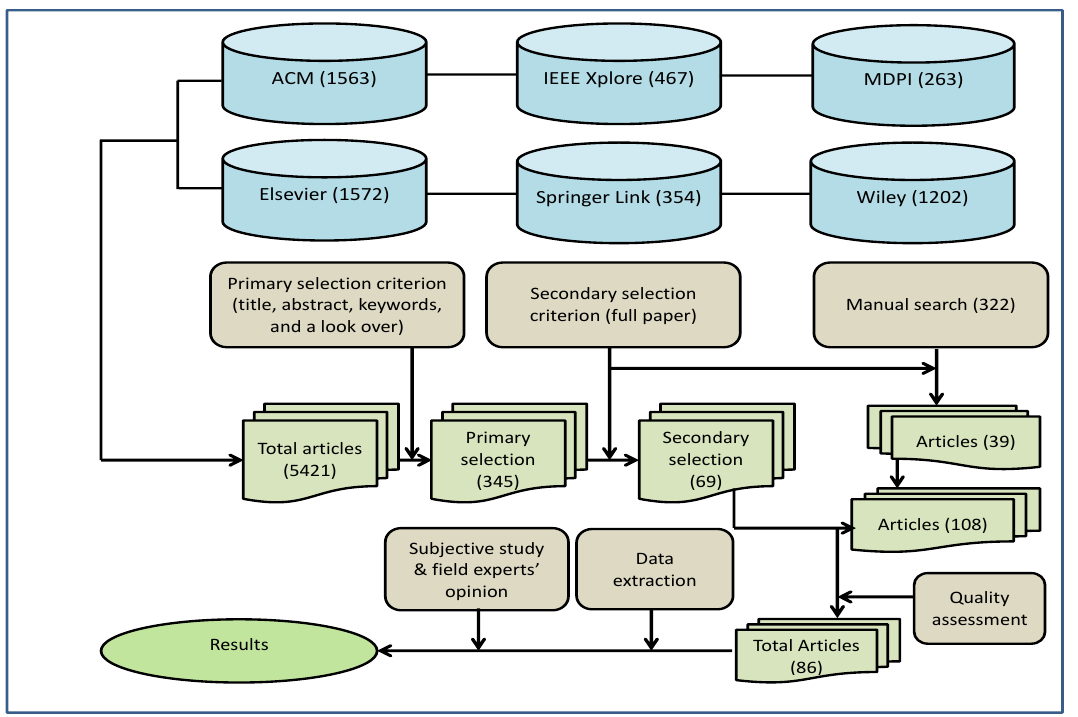
Figure 1. Research methodology, including search strategy, article selection criteria, quality assess- ment, and data